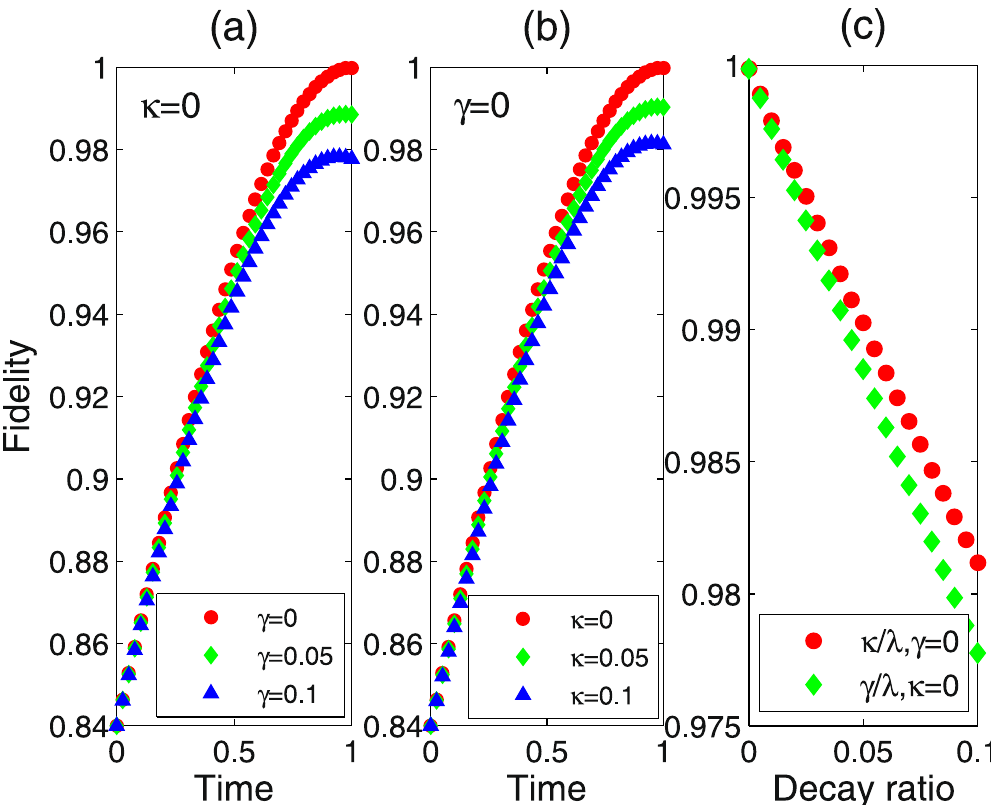
Figure 5. The fidelity of W state fusion scheme for the two atoms in one cavity with λ = 1, λ Ω = . 0 01 , Δ = 0.8 λ . ( a ) Fidelity of the fusion varies with t when γ = 0, 0.05 λ , 0.1 λ , respectively. ( b ) Fidelity of the fusion varies with t when κ = 0, 0.05 λ , 0.1 λ , respectively. ( c ) Fidelity of the fusion varies with decay ratio. Red circle is the fidelity varies with κ / λ when γ = 0. Green rhombus is the fidelity varies with γ / λ when κ =